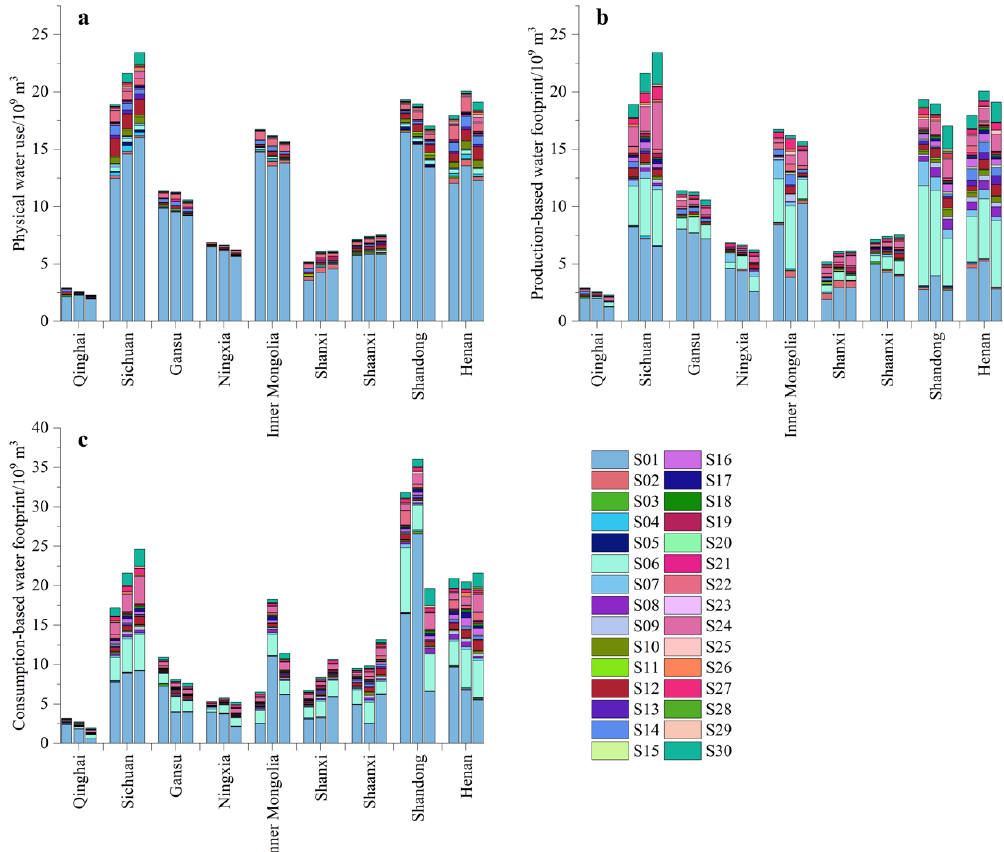
Figure 3. Physical water use ( a ), the production-based water footprint ( b ), and the consumption-based water footprint ( c ) for thirty sectors of the nine provinces in the Yellow River basin, 2007–2017.